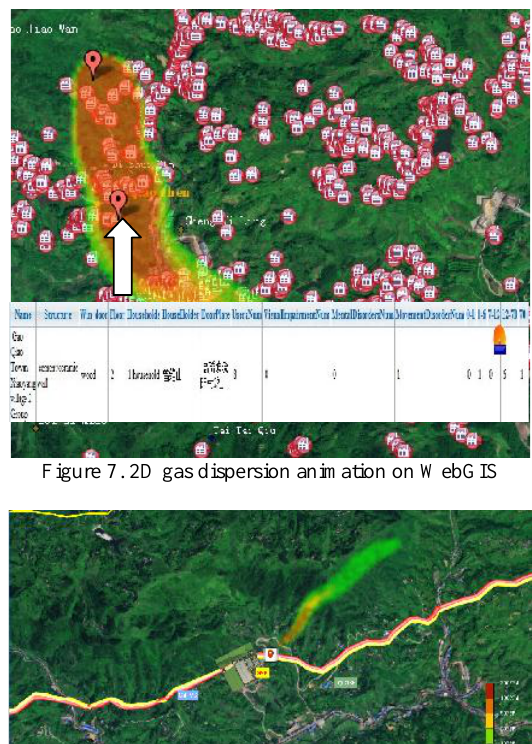
Figure 8. 3D gas dispersion animation on